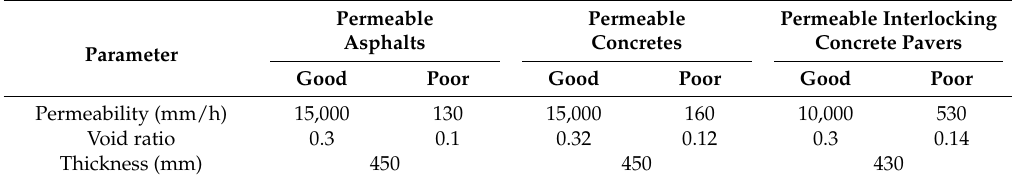
Table 2. Parameters of three permeable pavements.